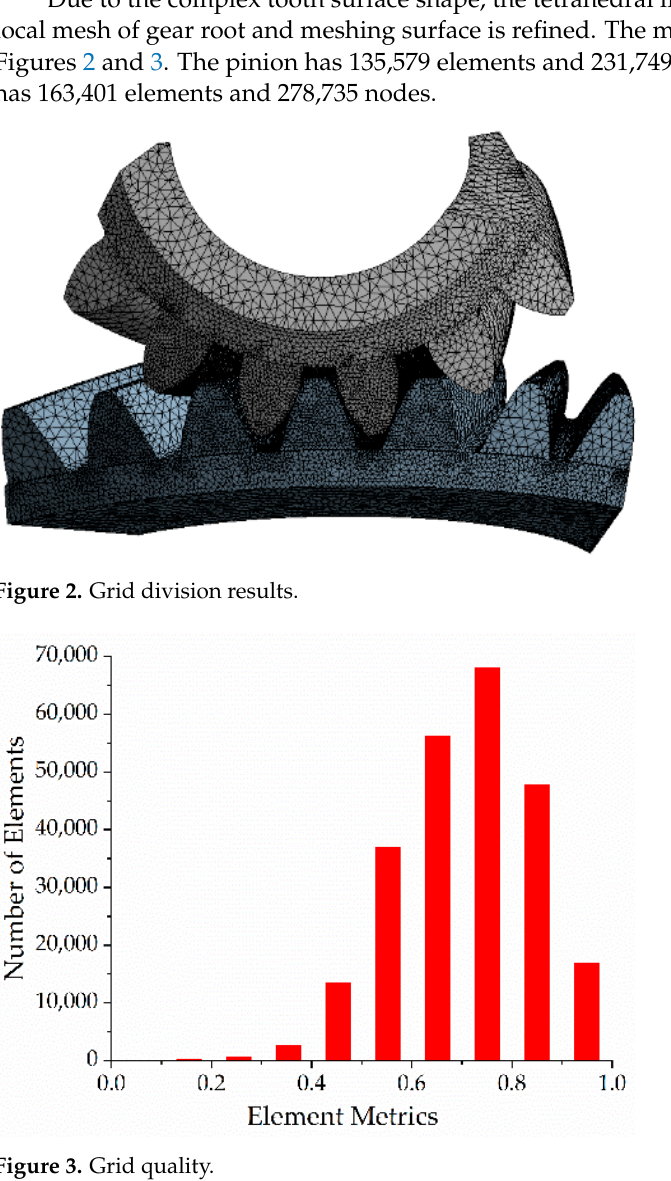
Figure 3. Grid Figure 3. Grid quality. Figure 3. Grid quality.